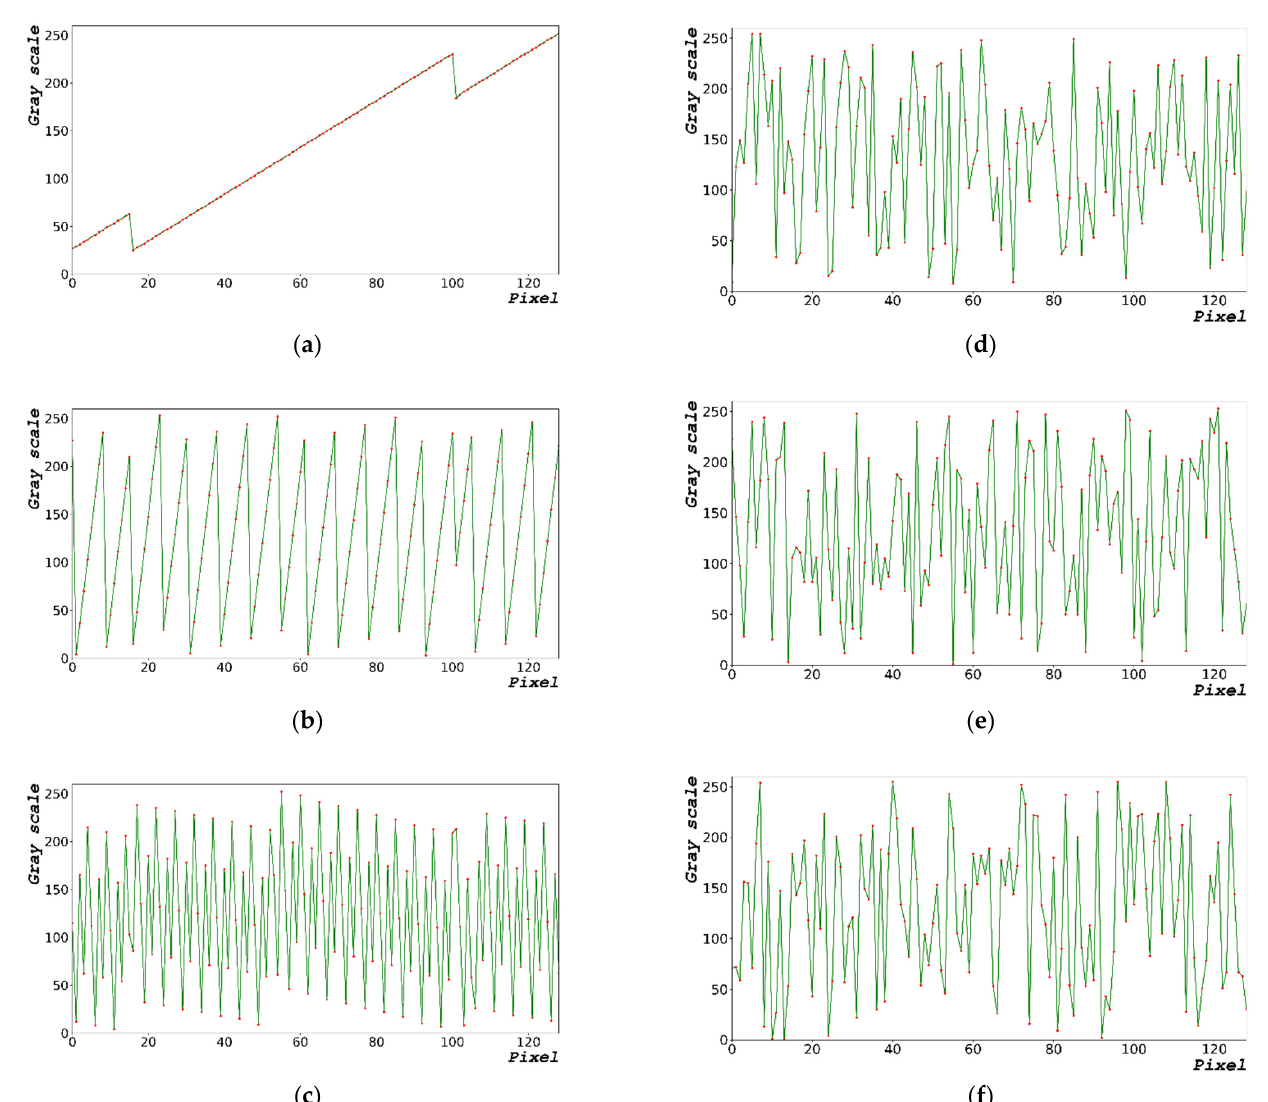
Figure 11. Comparison data for encrypting performance. Enlarged sections of Figures ( a ) 2b, ( b ) 2d, and ( c ) 2f. Enlarged sections of Figures ( d ) 8b, ( e ) 8d, and ( f ) 8f within 0–128 pixels.